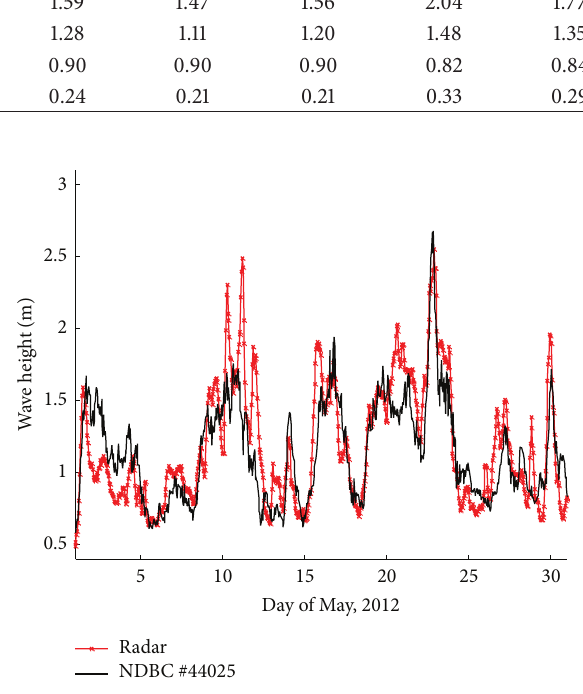
Figure 5: Significant wave height extracted from the SeaSonde at the BRMR site in May,